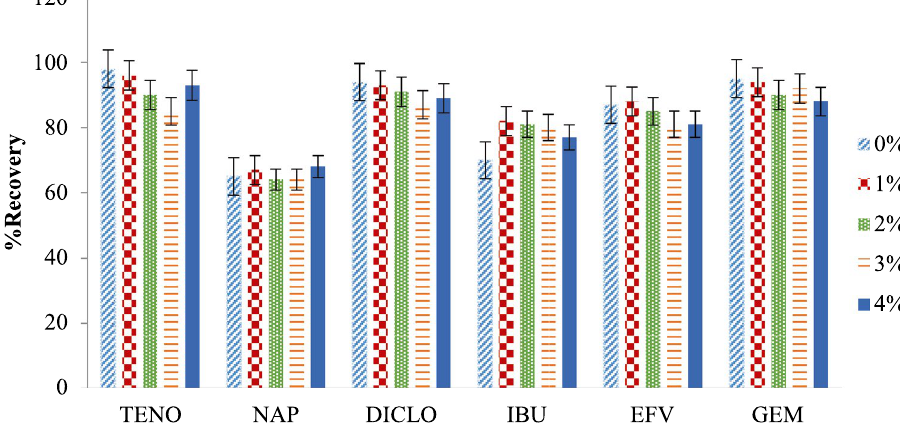
Fig. 2 The effects of percent- age NaCl content on the percentage